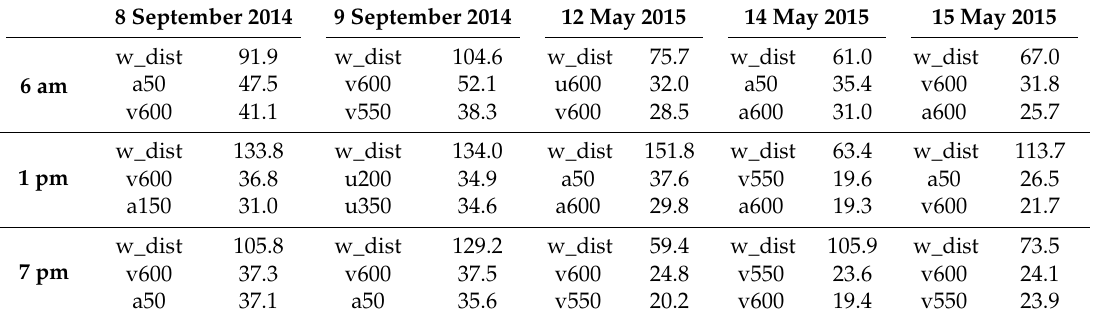
Table 5. Top three variables in terms of variable importance derived from RF. Each variable is described as follows: w_dist: distance to the coast, a: albedo, v: vegetation, u: urban, the number indicates the buffer